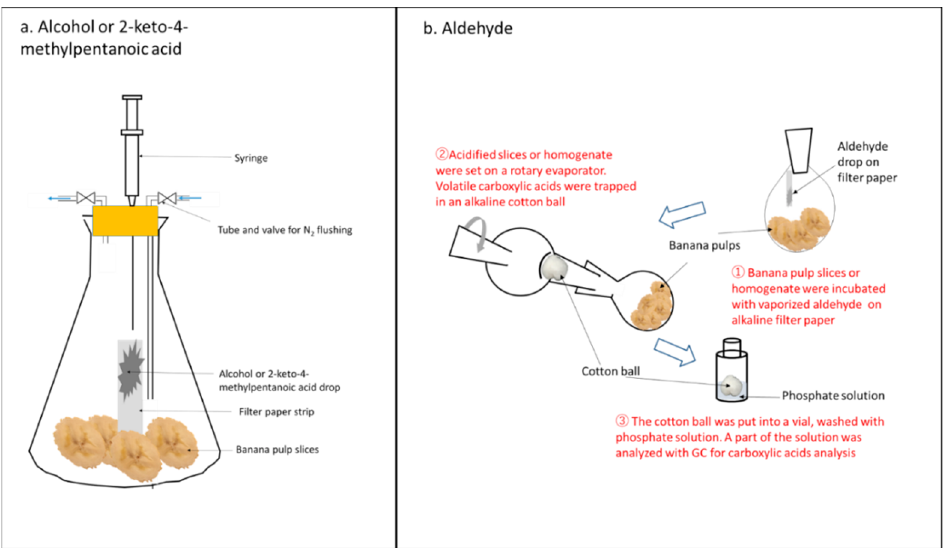
Figure 2. Feeding experiments procedures. ( a ) Feeding alcohol or 2-keto-4-methylpentanoic acid feeding to banana pulps to produce alcohol/aldehyde/esters in air or nitrogen gas. ( b ) Incubating aldehyde vapor with banana pulps to produce corresponding carboxylic acid, and separation of the carboxylic acid from pulps.